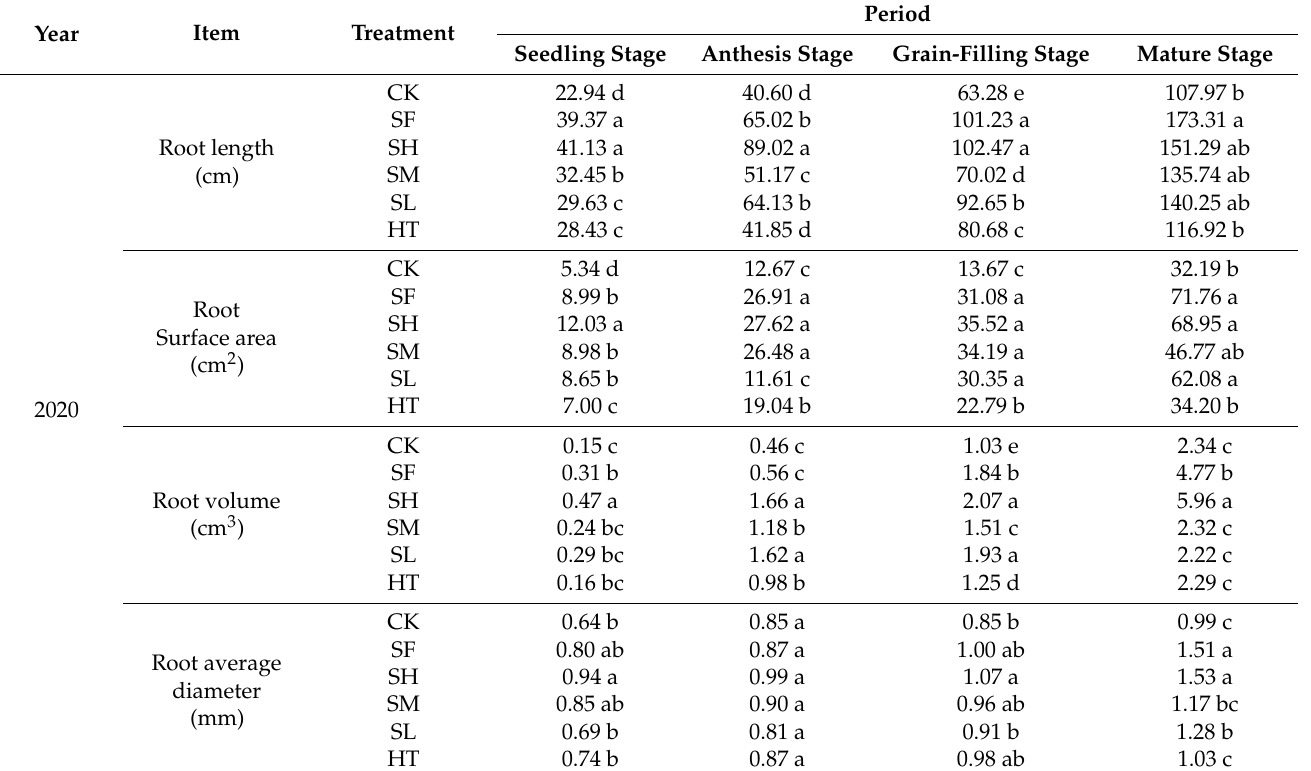
Table 5. Effect of rice straw combined with inorganic fertilizer on the root